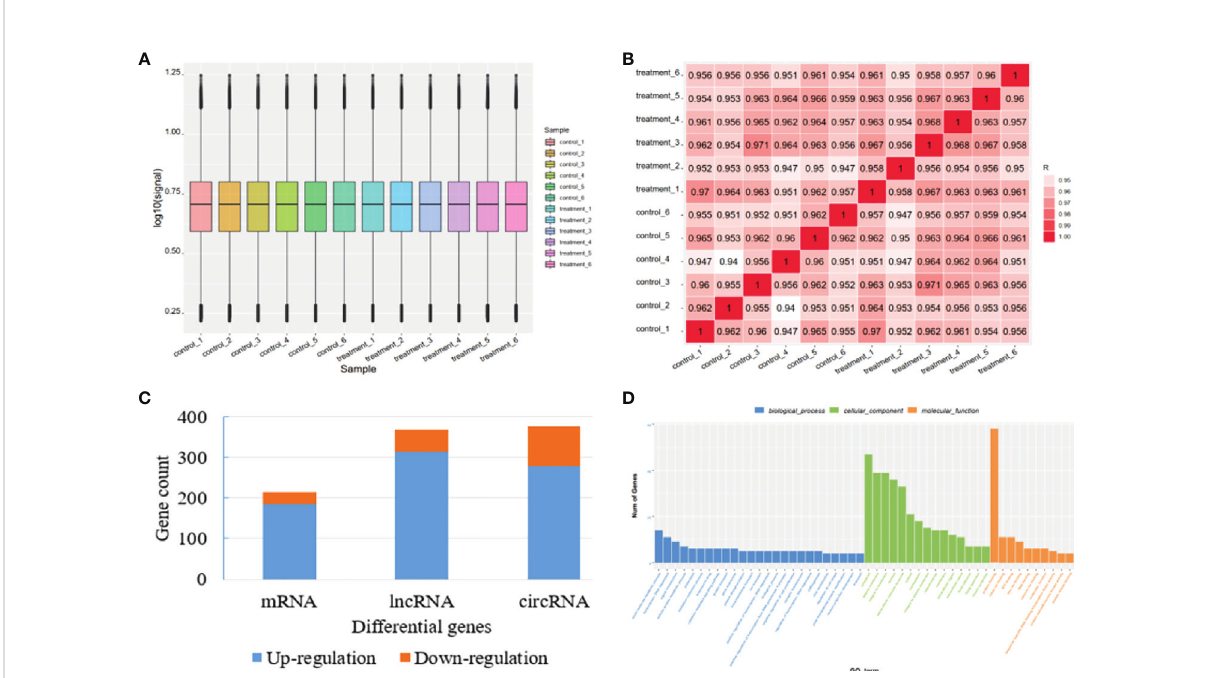
FIGURE 1 Quality control for microarray data and overview of the differential genes. (A) RNA expression boxplot. (B) Global gene expression correlation analysis across samples. (C) The number of differential genes in mRNA, lncRNA, and circRNA. (D) Differential gene count in different GO